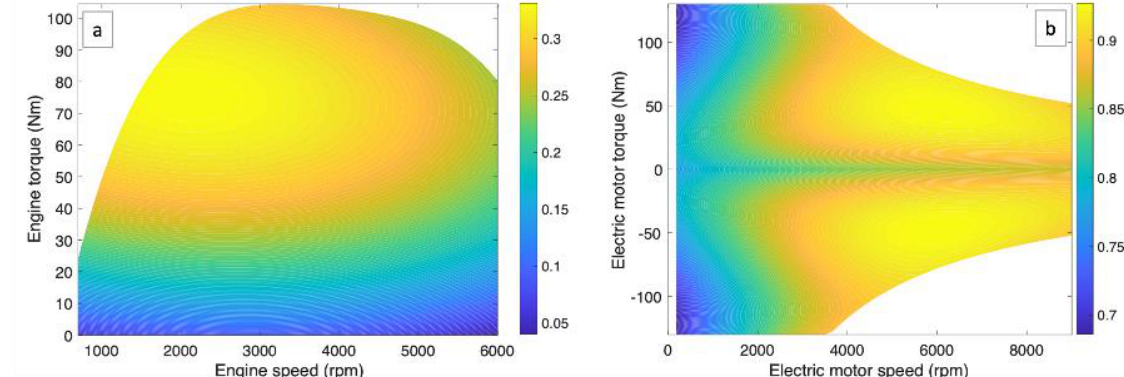
Figure 2. SI engine ( a ) and electric motor ( b ) efficiency maps as a function of speed and torque.